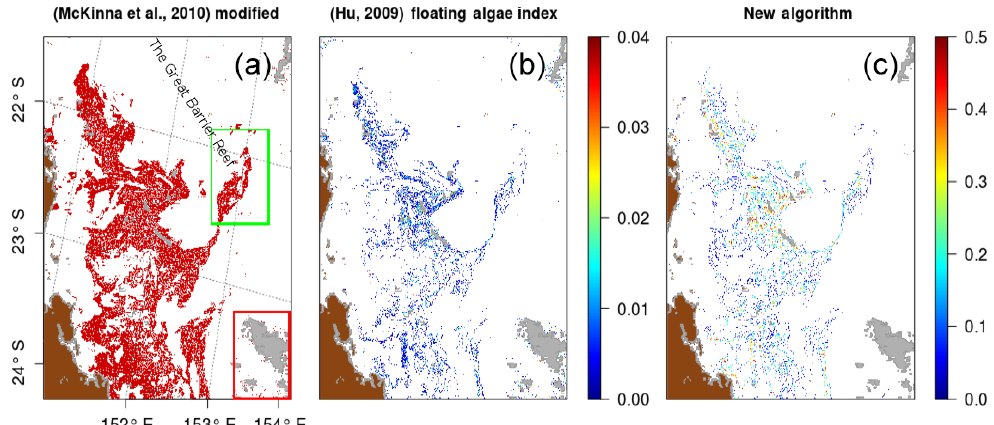
Figure 5. Trichodesmium mat detection results on MODIS tile “A2007290.0355”. (a) Detected pixels with the McKinna modified algorithm in red; (b) FAI value of detected pixels with the FAI algorithm; (c) pixels detected with the new algorithm, and color represents the R rs ( 678 ) absolute value of the detected pixels. Cloud pixels are in